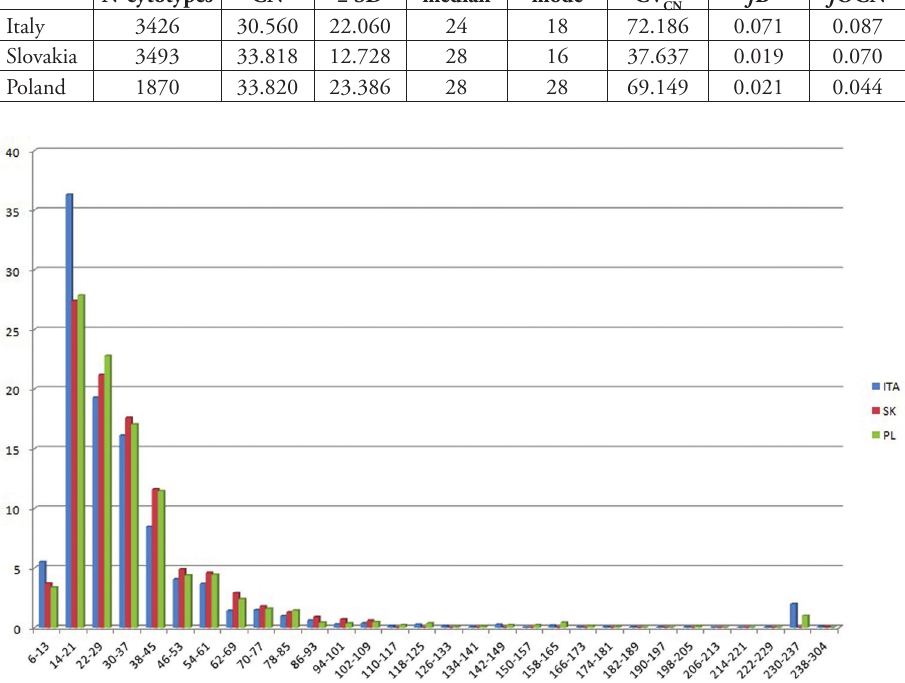
Figure 1. Histograms showing the percentage frequencies (y-axis) of 2n chromosome numbers, grouped in classes (x-axis) known for the Italian (ITA), Slovak (SK) and Polish (PL) vascular